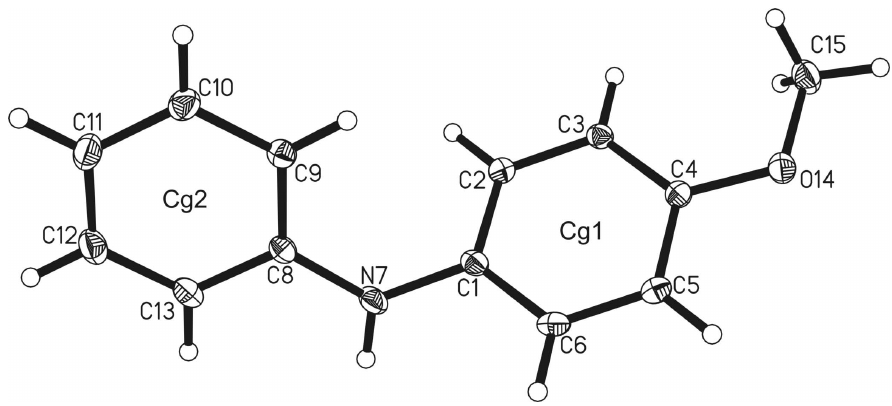
Figure 1 The molecular structure of the title molecule, with the atom-numbering scheme. Displacement ellipsoids are drawn at the 25% probability level. Cg 1 and Cg 2 denote the ring centroids.